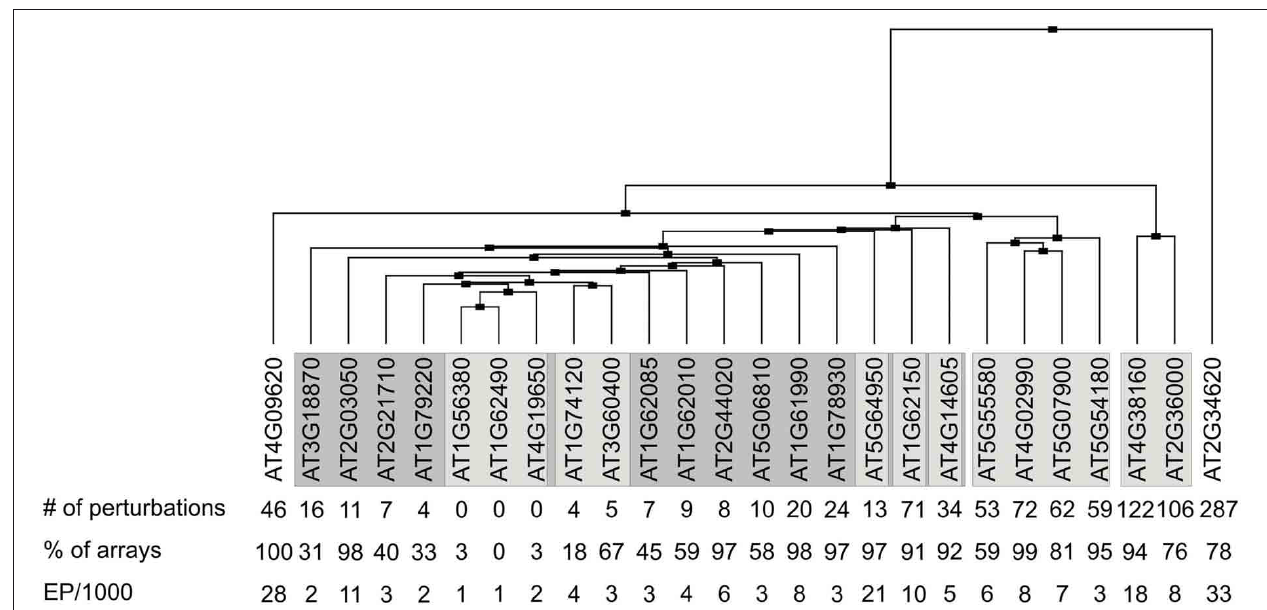
number of perturbations (for example chemicals, hormones, stress and mutations) that evoke ≥ 2-fold changes in the levels of MTERF mRNAs; % of arrays, the value indicates the percentage of microarray datasets in Genevestigator that detected the presence of transcripts of the various MTERF genes; the expression potential (EP) was divided by